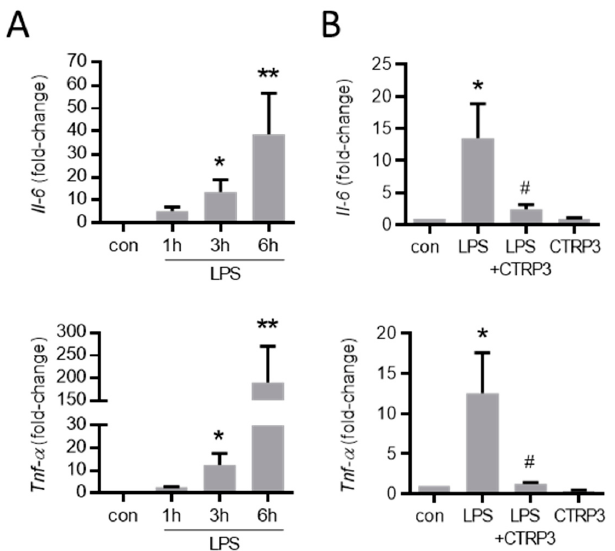
Figure 3. LPS-induced cytokine expression in endothelial cells is inhibited by CTRP3. ( A ) MyEnd (myocardial endothelial) cells were stimulated with LPS (lipopolysaccharides, 50 ng/mL) for the indicated period. The mRNA levels of Il-6 (interleukin-6) and Tnf- α (tumor necrosis factor- α ) were analyzed by real-time PCR. * p < 0.05, ** p < 0.01 vs. con = unstimulated control, n = 5–6. ( B ) MyEnd cells were stimulated with LPS (50 ng/mL) alone or pretreated with CTRP3 (C1q/TNF-related protein 3, 10 µg/mL, for 30 min) and CTRP3 alone for 3 h. Il-6 and Tnf- α mRNA levels were analyzed by real-time PCR. * p < 0.05 vs. con = unstimulated control, # p < 0.05 vs. LPS, n = 4–6.